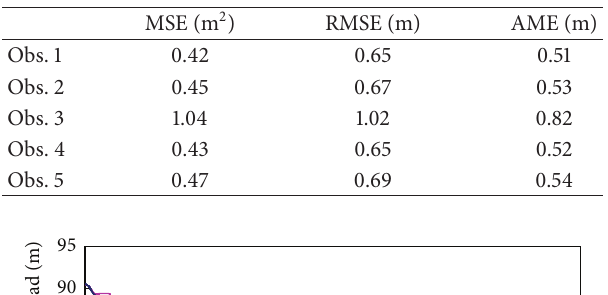
Table 5: Validation results in subsurface water ANN model.